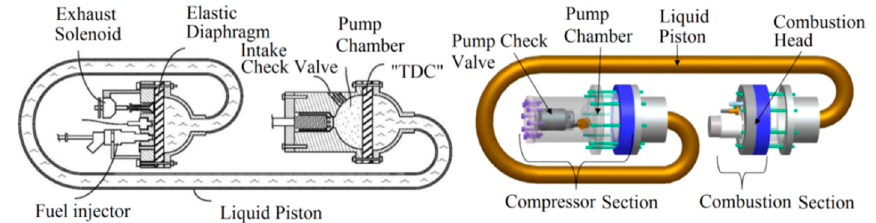
Figure 21. The HFPE principle prototype of University of Michigan [55].